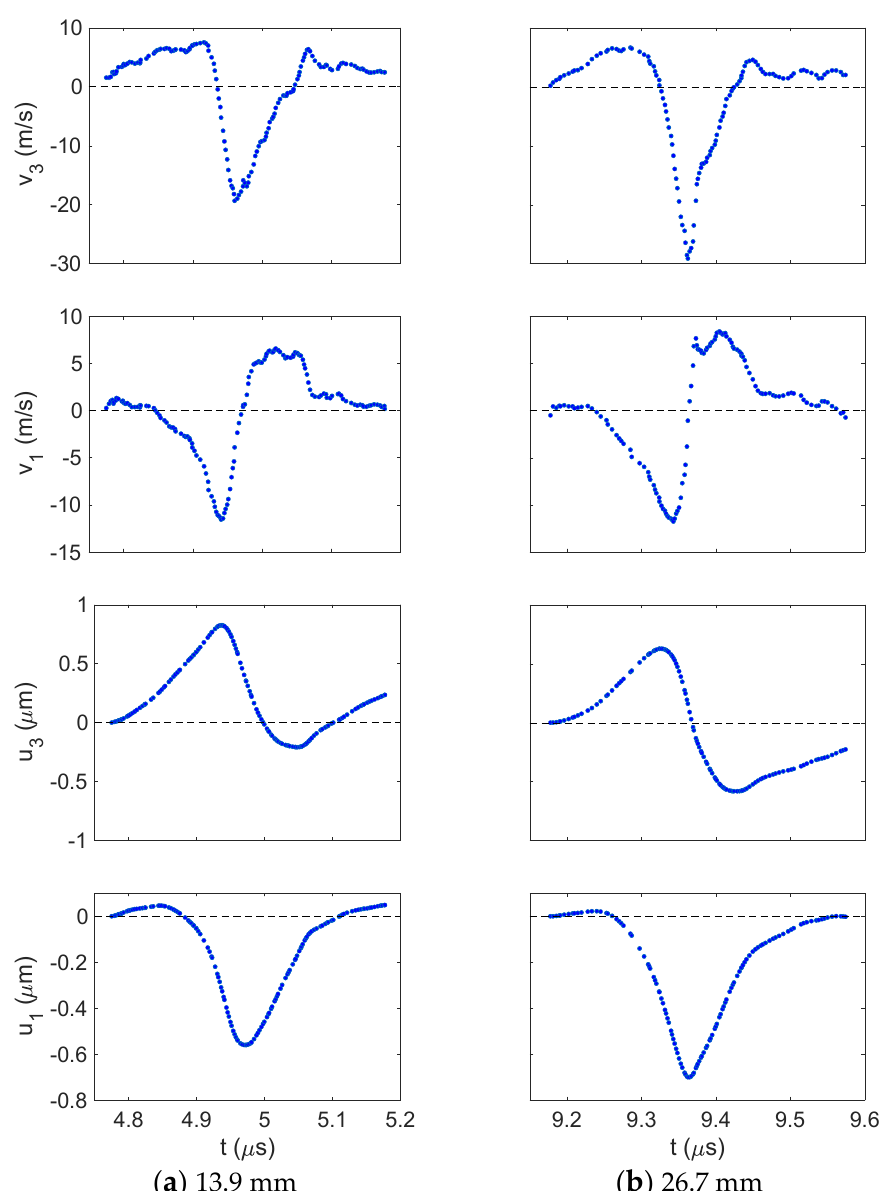
Figure 2. Particle velocity and displacement waveforms from aluminum substrate at ( a ) 13.9 mm and ( b ) 26.7 mm. v 3 was detected by Kolomenskii and Schuessler [14] and digitized by us, then v 1 was computed using the Hilbert transform, and finally u 3 and u 1 were computed by numerical integration. All waveforms are at the surface x 3 = 0.